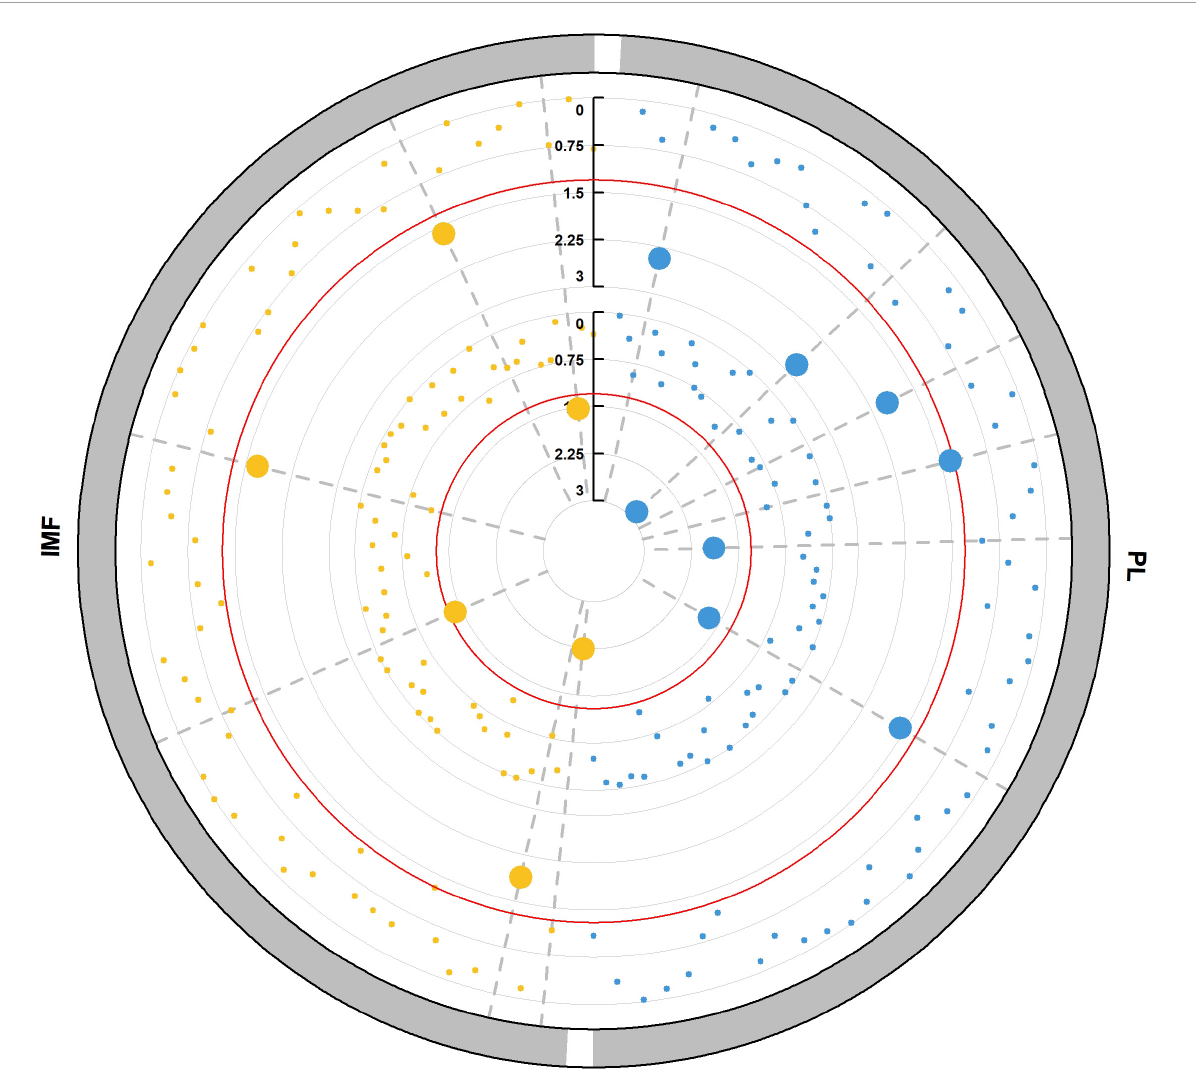
FIGURE2 Microbial detections via Wilcoxon rank-sum tests between divergent groups. Microbial abundance in the highest 20% group with lowest 20% group traits. Displayed from the outer to the inner circle is the trait, the significance test in trait between the two groups with the highest and lowest microbial abundance ( P m − trait ), the significance test in each microbial abundance between the highest and lowest trait ( P trait - m ), where p-values are plotted as –log10 ( p-value ); the red line shows the significance threshold ( P < 0.05). Each point represents a microbe, and the big point indicates the p -value passed the significance threshold. The dot on the same gray dashed line indicates that the P m − trait and P trait - m values for one microbe are all <